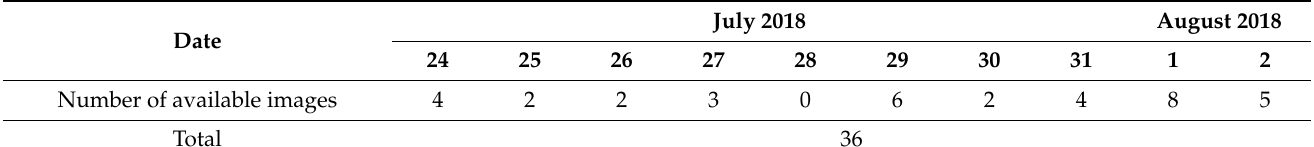
Table 2. PlanetScope imagery available during M. polykrikoides bloom event in the southern coast of Korea,